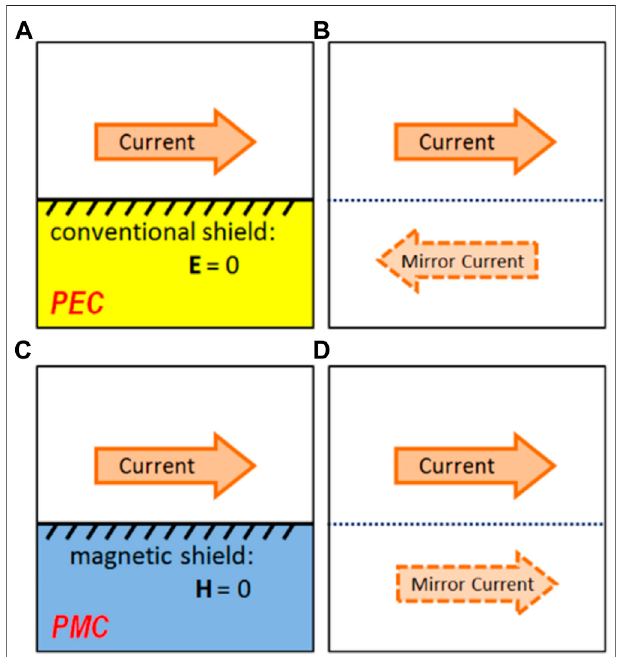
FIGURE1| Illustrationofhowthemethodofmirrorcurrentscanbeused to describe shielded currents. (A) A conventional shield with high electric conductivity (modeled as a perfect electric conductor) does not allow electric fi elds to penetrate. As a result, the tangential component of the electric fi eldiszeroattheboundary. (B) Anout-of-phasemirrorcurrentattheopposite side of the shield (dotted line) satis fi es the same boundary condition on the shieldandrealizesthesame fi elddistributions. (C) Amagneticshield(modeled as a perfect magnetic conductor) does not allow magnetic fi elds to penetrate. As a result, the tangential component of the magnetic fi eld is zero at the boundary. (D) An in-phase mirror current at the opposite side of the shield (dotted line) satis fi es the same boundary condition on the shield and realizes the same fi eld distributions.